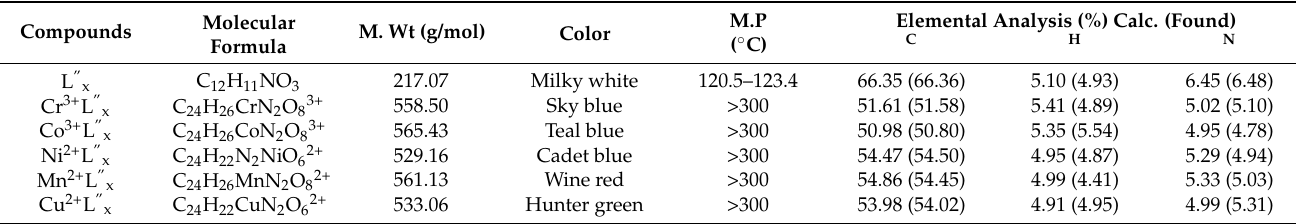
Table 1. Physical Properties and analytical data of compounds 3 – 8 .